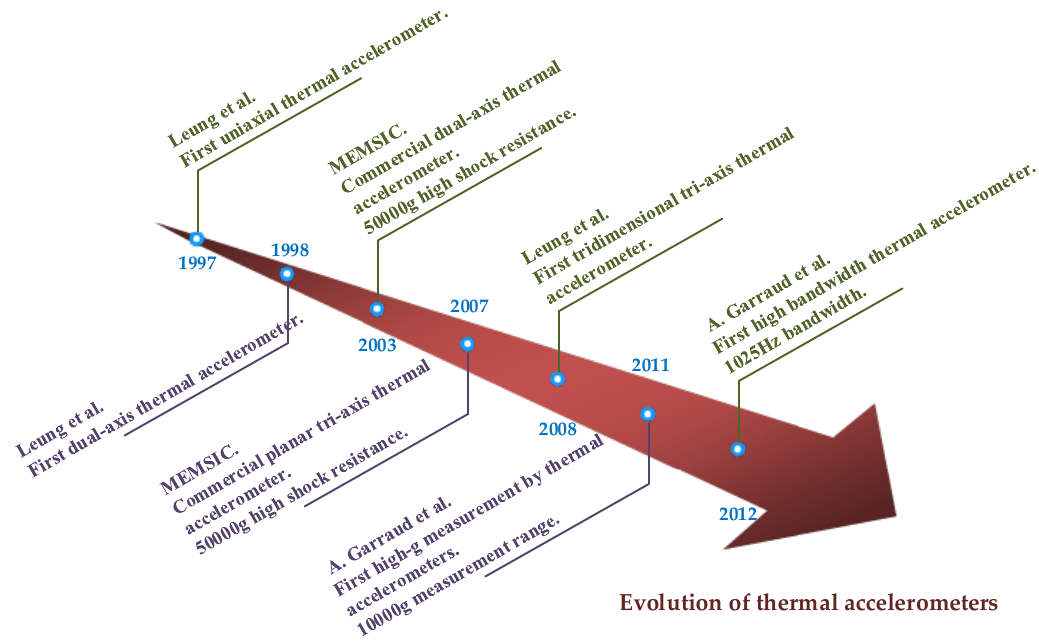
Figure 7. A brief chronology of the evolution of micromachined thermal accelerometers.